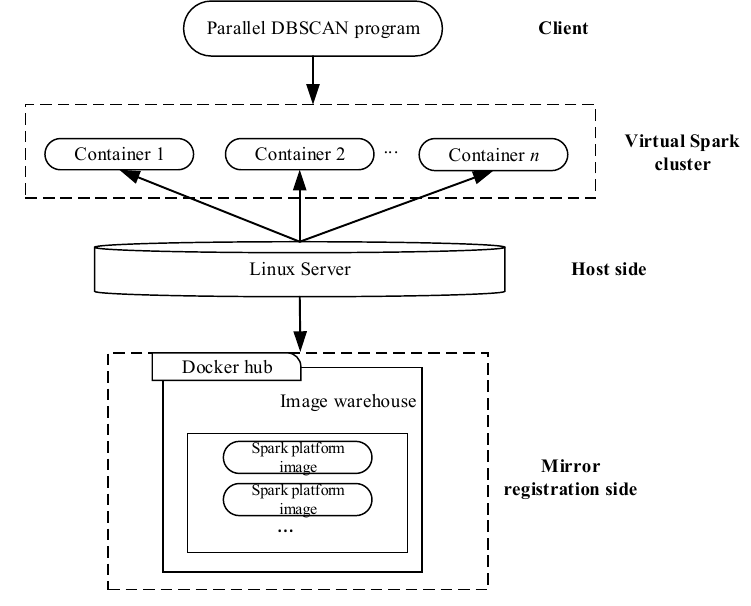
Figure 14. Parallel DBSCAN algorithm based on a Docker-based virtual Spark cluster.